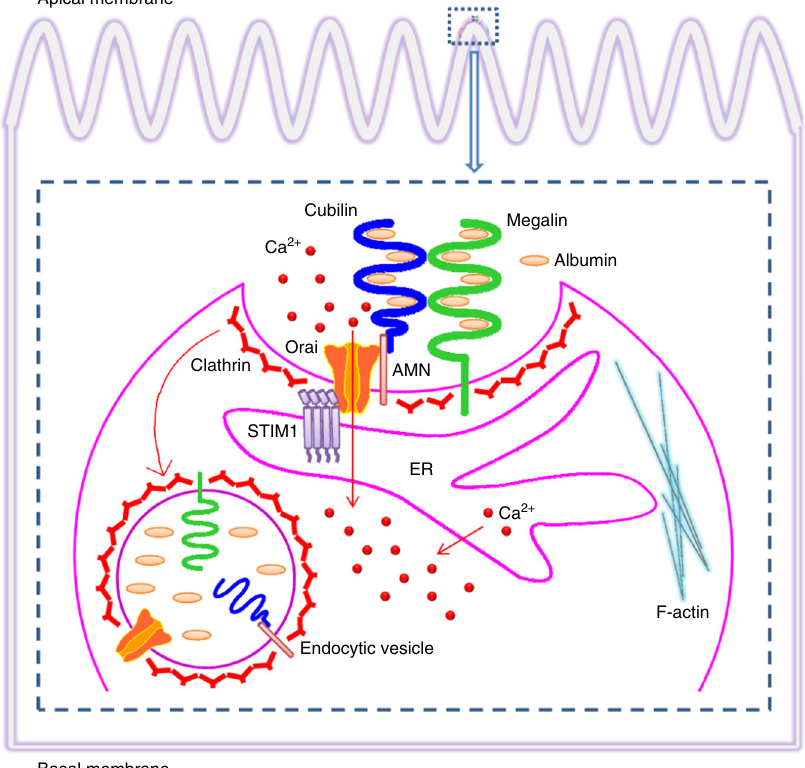
Fig. 8 Model for ORAI/STIM and endocytic receptors in the process of albumin endocytosis Endoplasmic reticulum Ca 2+ store-depletion induces intracellular STIM1 movement and subplasmalemmal clustering, and forms ORAI/STIM1 complexes. The ORAI/STIM1 complexes physically associate with amnionless (AMN) to form triple complexes (ORAI/STIM1/AMN). Such triple complexes, together with cubilin and megalin, are endocytosed via clathrin- mediated endocytic mechanism during the PTECs exposure to albumin, which in turns leads to decreased activity of store-operated Ca 2+ entry in the